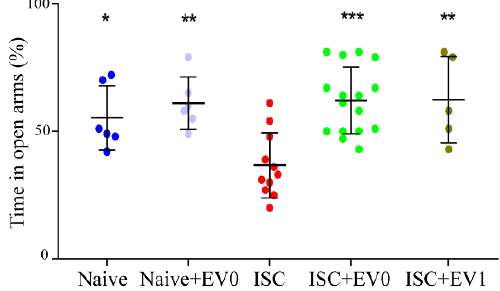
Figure 8. Elevated plus-maze task. Session was performed on day 7 after treatment. Groups: naive (n = 6), naive + EV0 (n = 6), ISC (n = 11), ISC + EV0 (n = 16), and ISC + EV1 (n = 5). Statistical analysis using the unpaired t test. Data are reported as mean ± SD, * p < 0.05, ** p < 0.01, *** p <